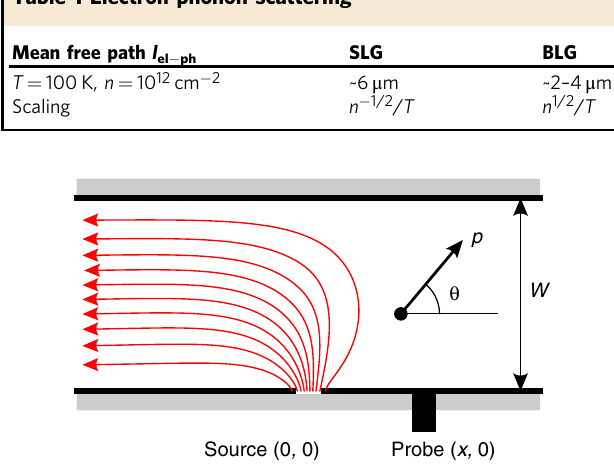
Fig. 5 The vicinity geometry in a strip of width w . The red lines illustrate current injected through the source at x = 0 and drained far to the left, at x = − ∞ . Voltage probe, positioned at a distance x from the source, is used to measure potential V p ( x ) relative to the ground far to the right, at x = + ∞ . The source and drain contacts, as well as the probe, were positioned at the y = 0 boundary. The angle θ between the electron momentum p and the strip edge parameterizes states at the two-dimensional Fermi surface